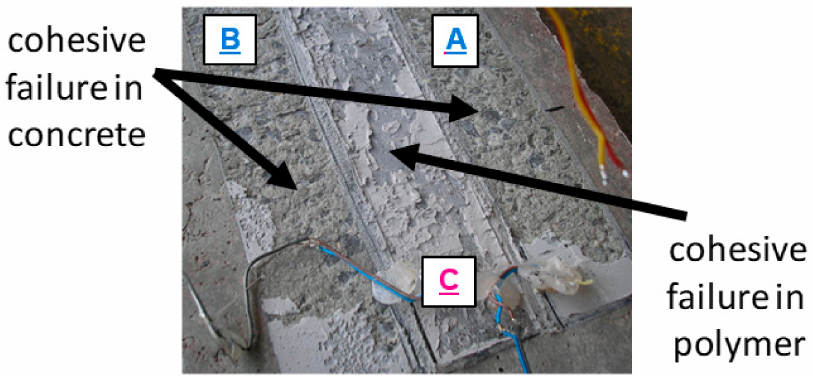
Figure 10. The bottom of the tested beam after the laminate detachment: side laminates (A and B)—brittle failure in concrete, middle laminate (C)—ductile failure in the adhesive layer.